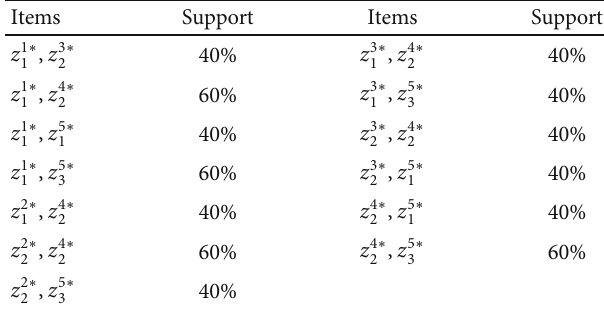
Table 4: Frequent item set L